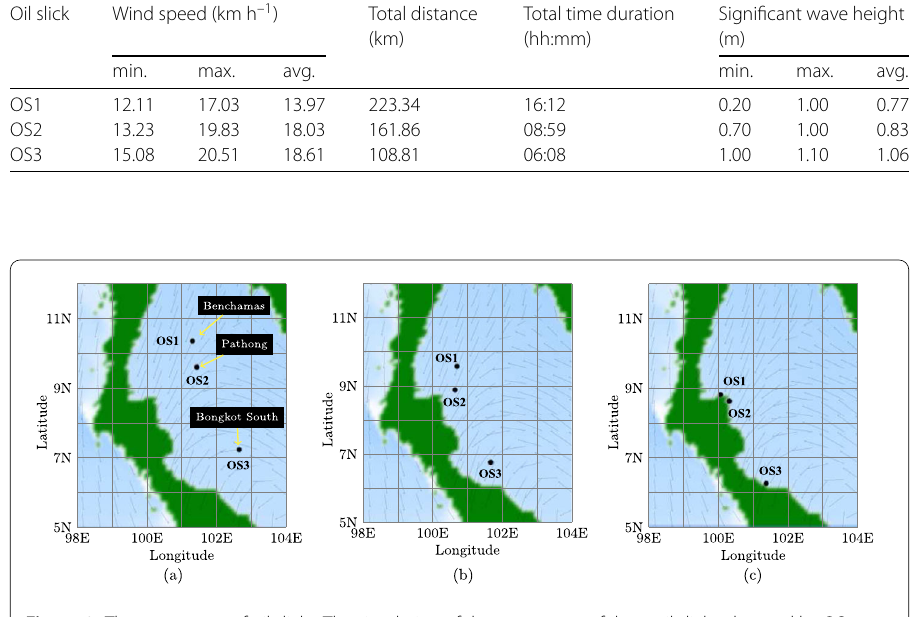
Figure 2 The movement of oil slicks. The simulation of the movement of three oil slicks, denoted by OS1, OS2, and OS3, originating from the different drilling rigs on 4 January 2019, a day with the tropical cyclone Pabuk. Three snapshots are illustrated: ( a ) when the oil slicks occur at the rigs, ( b ) when they drift to the sea surface, and ( c ) when they land on the coastal areas